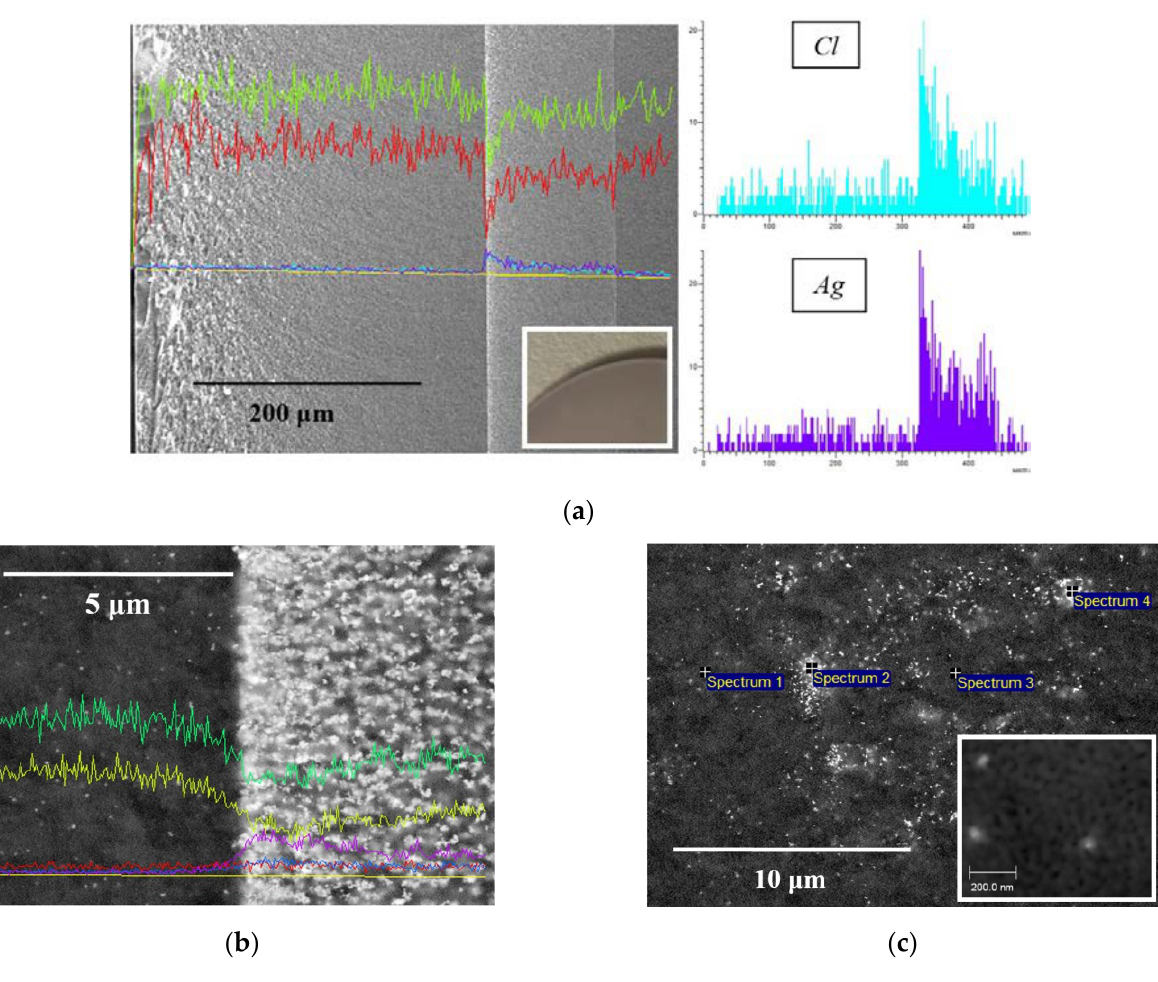
Figure 6. SEM image and element distribution of the cross-section of the Ag/AgCl/MAP membrane: Si—green, O—red, Cl—blue, Ag—purple ( а ), Si—green, O—yellow, Cl—blue, Ag—purple, C—red ( b ) ; spectra containing (1, 2, 4) and not-containing (3) silver element ( c ).